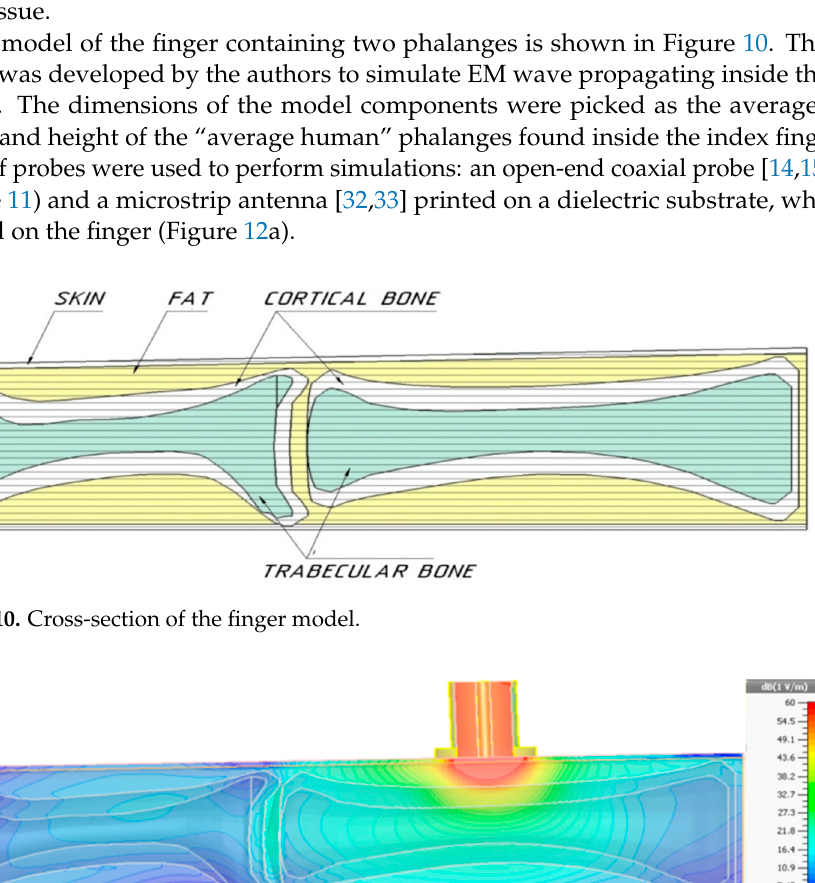
Figure 11. Electric field distribution within the finger volume excited by the open-end coaxial